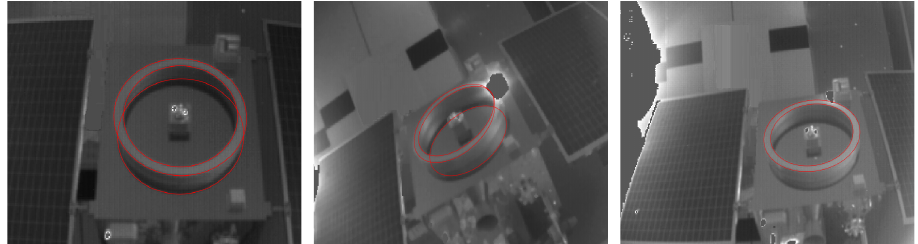
Figure 8. Some good results of ellipse-detection based on arc